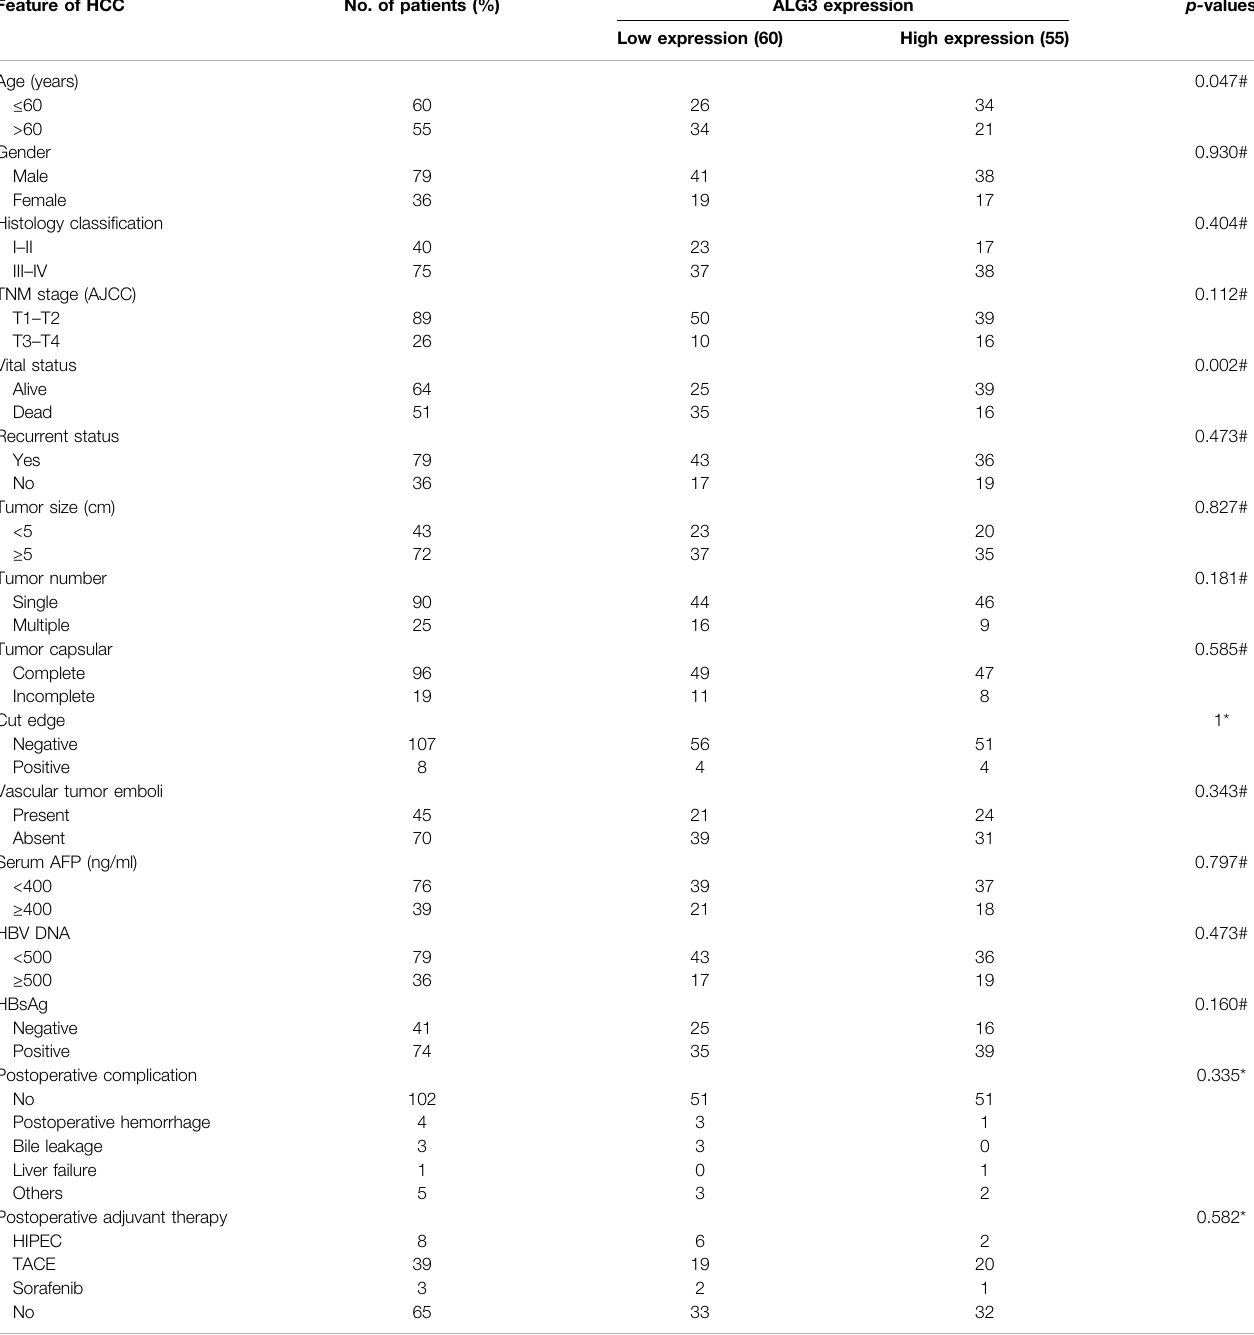
TABLE 1 | Association between the ALG3 expression and other clinicopathologic features. Feature of